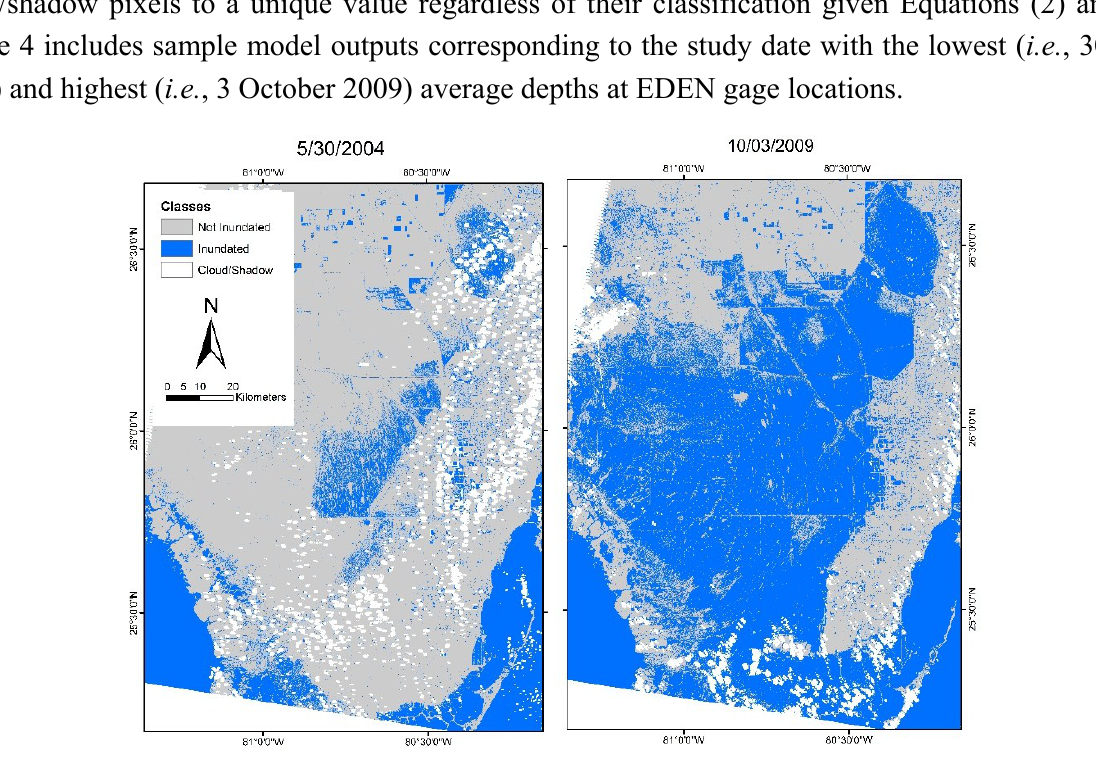
Figure 4. Open ( i.e. , vegetation free) water is relatively rare in the Everglades. Therefore, Landsat-based classification techniques that identify pure water pixels suggest the vast Everglades “river of grass” is overly dry. In contrast, the application of Equations (2) and (3) yields maps of inundation for the driest ( left ) and wettest ( right ) image dates in the study image database. Blue pixels are those that met the trial model criteria and were not masked as cloud/cloud shadow (white